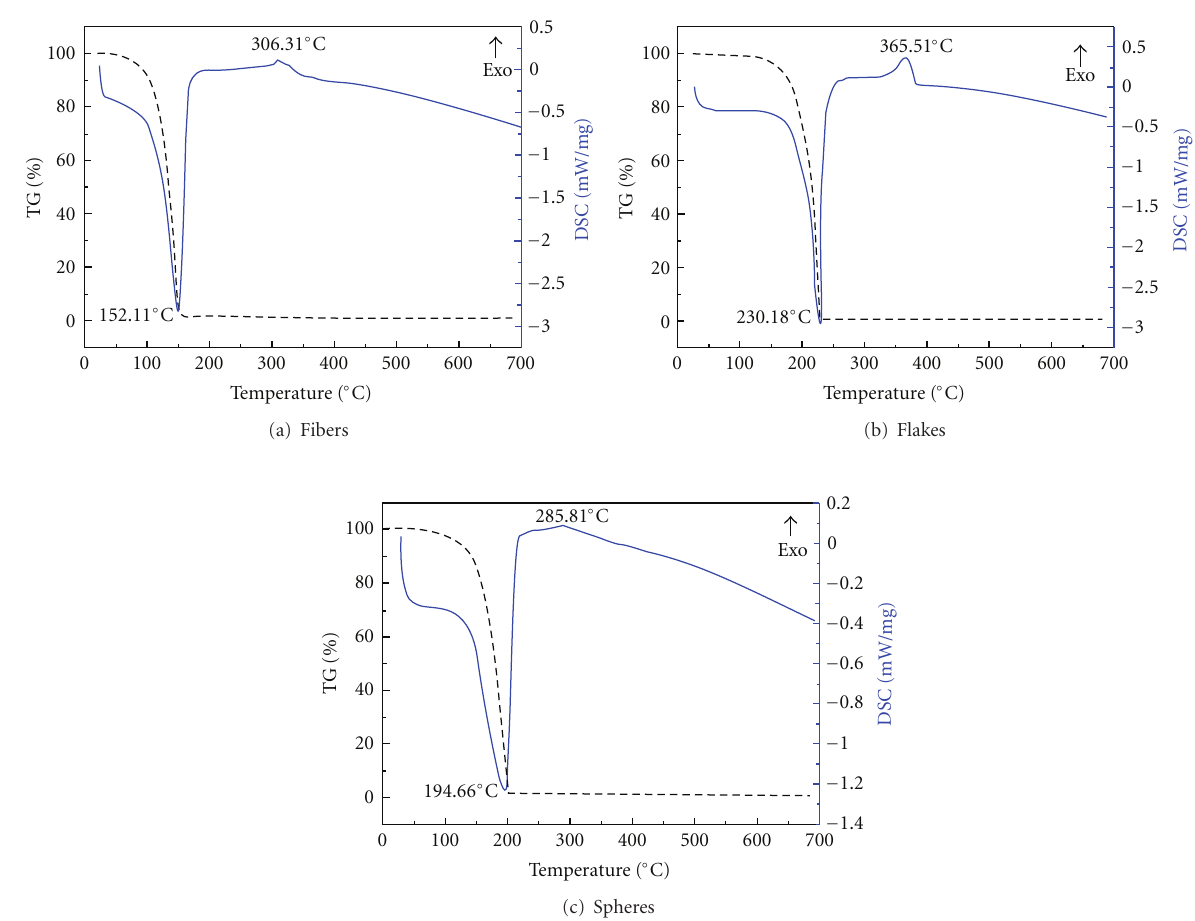
Figure 6: TGA/DSC graphs of the precursor of various ZnO structures: (a) fibers, (b) flakes, and (c)